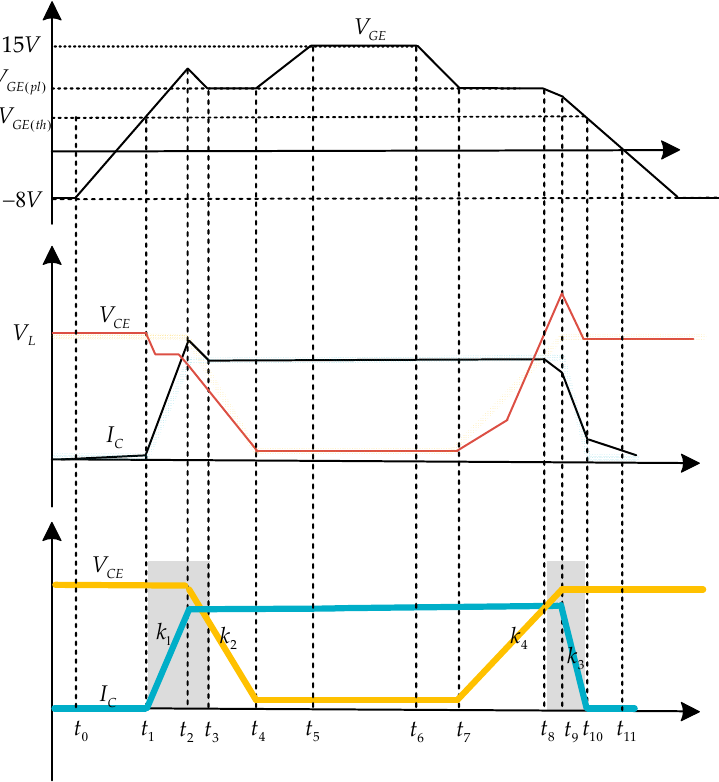
Figure 6. Waveform of the collector current and the collector–emitter voltage drop of IGBTs.